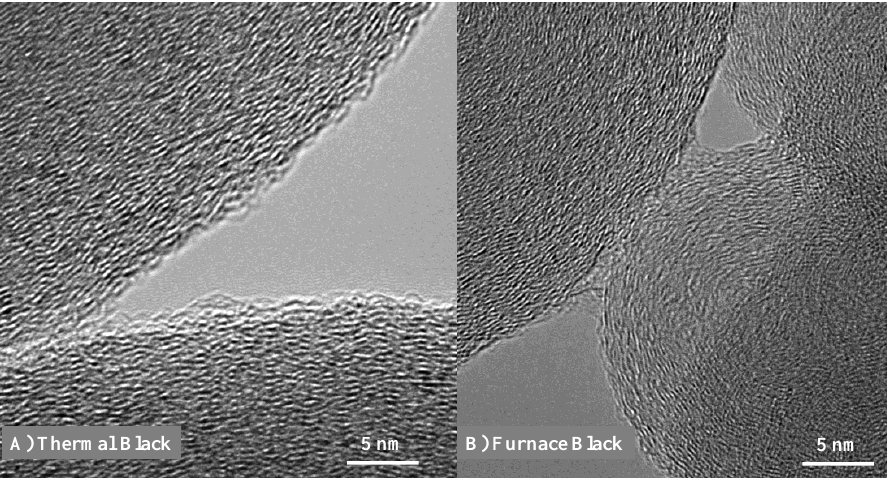
Figure 5 . TEM image showing nanostructure of ( A ) thermal and ( B ) furnace black particles.